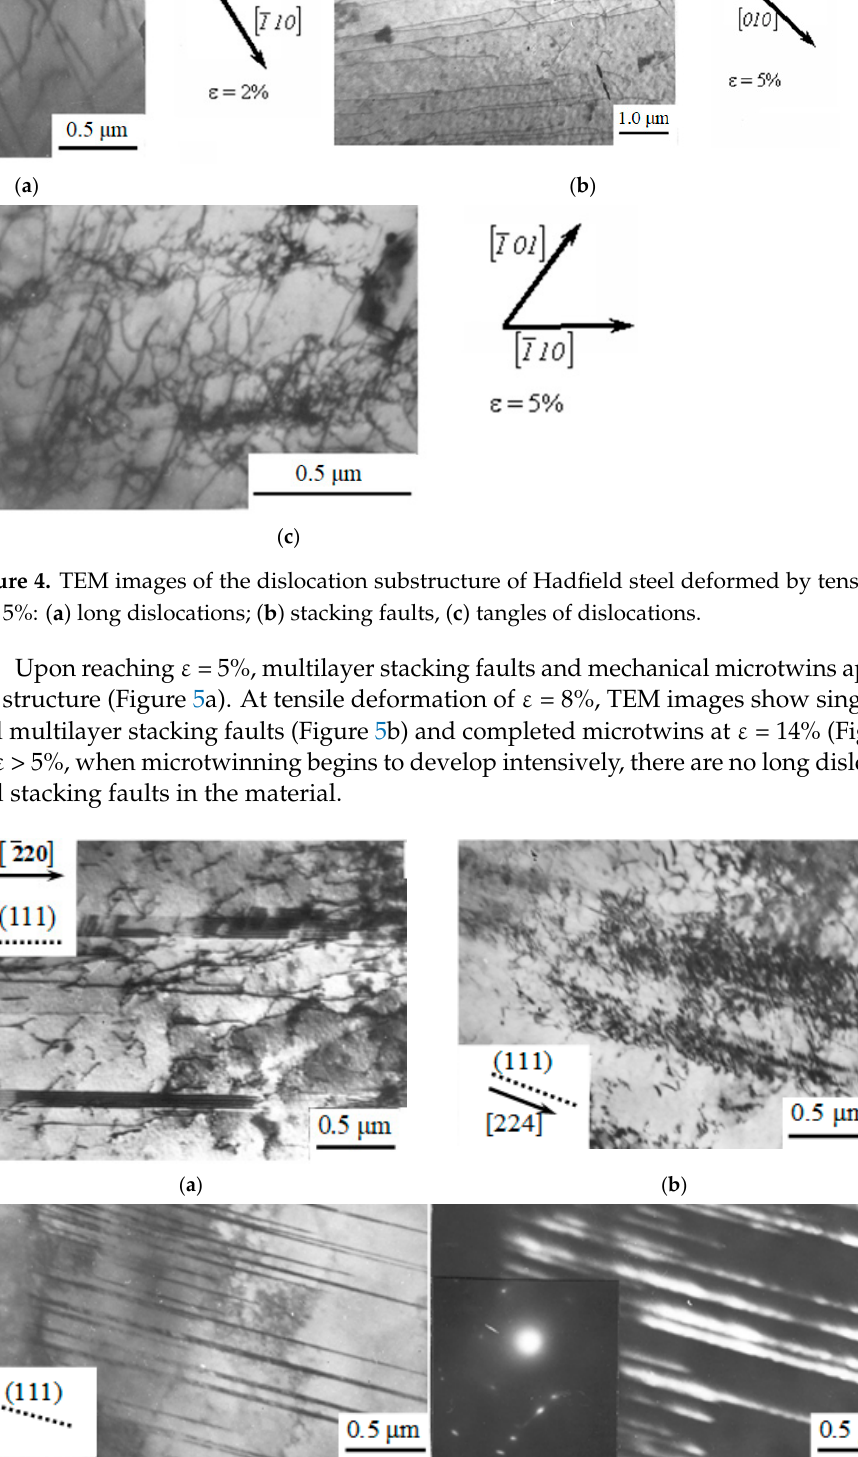
Figure 5. Stages of deformation twins formation in Hadfield steel deformed by tension with ε = 5% ( a ); ε = 8% ( b ); ε = 14% ( c ): single-layer ( a ), multilayer ( b ) stacking faults (incomplete twinning) and microtwins ( c ) (complete twinning). The dotted line marks the trace of the habit (111) plane. Thus, at the initial tensile deformation degrees within the initial grains, the formation of a dislocation substructure begins. With an increase in the degree of plastic deformation, the density of dislocations at the subboundaries increases, and the crystallographic miso- coefficient when the degree of deformation reaches 5%, as shown in Figure 1. In previous studies [12,30,31], the authors associated the linear nature of the harden- ing of Hadfield steel during deformation with sliding deformation and mechanical twin- ning, explaining that the hardening caused by a change in the microstructure at room temperature is explained by twinning in materials of this type in the same way as it is described for the Hall-Petch effect. The dynamic Hall-Petch effect from the microstruc- tural refinement by the formation of the multiple domain walls is stated in [32], however, the long-range interaction between the pile-up dislocations is highlighted in the mecha- nisms in [11,33,34]. In contrast to [11], a sharp decrease in the strain hardening coefficient